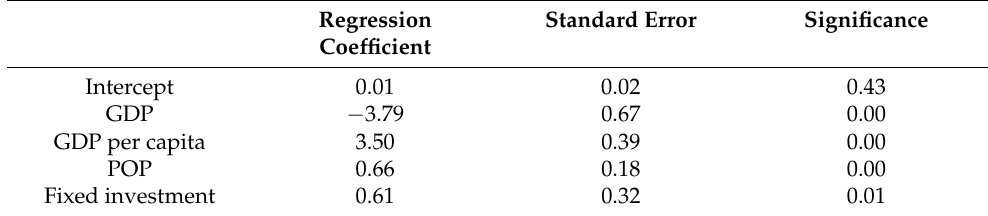
Table 4. Regression coefficient of LPI with GDP, GDP per capita and fixed investment (R square is 0.99). Regression